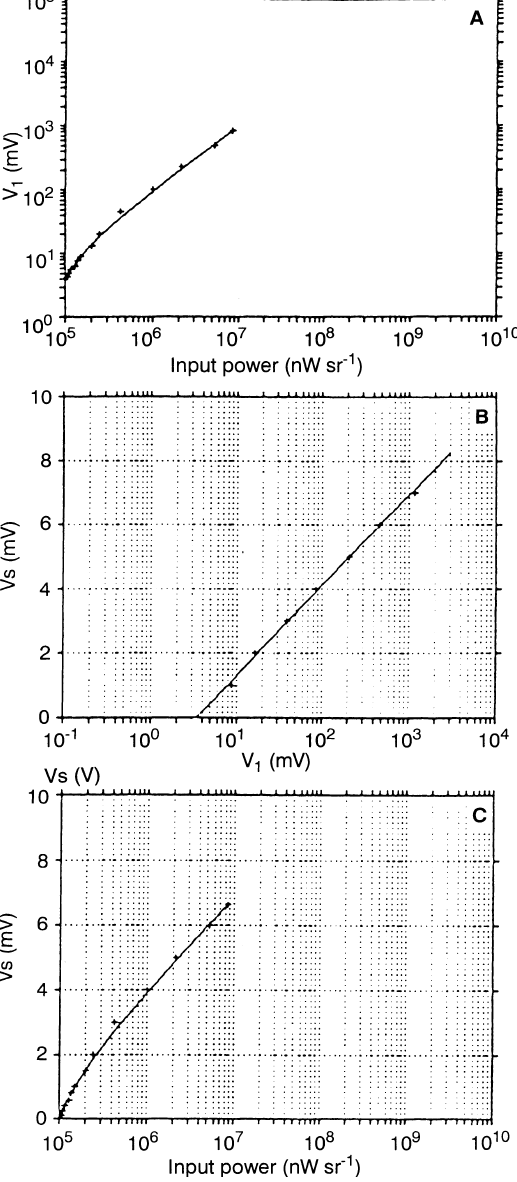
57 (cid:176) ) Fig. 12A–C. Same as Fig. 10. Results of the calibration of the (cid:136) detector 4 ( (cid:104) 9.02 (cid:176) ) equipped with optical (cid:136)